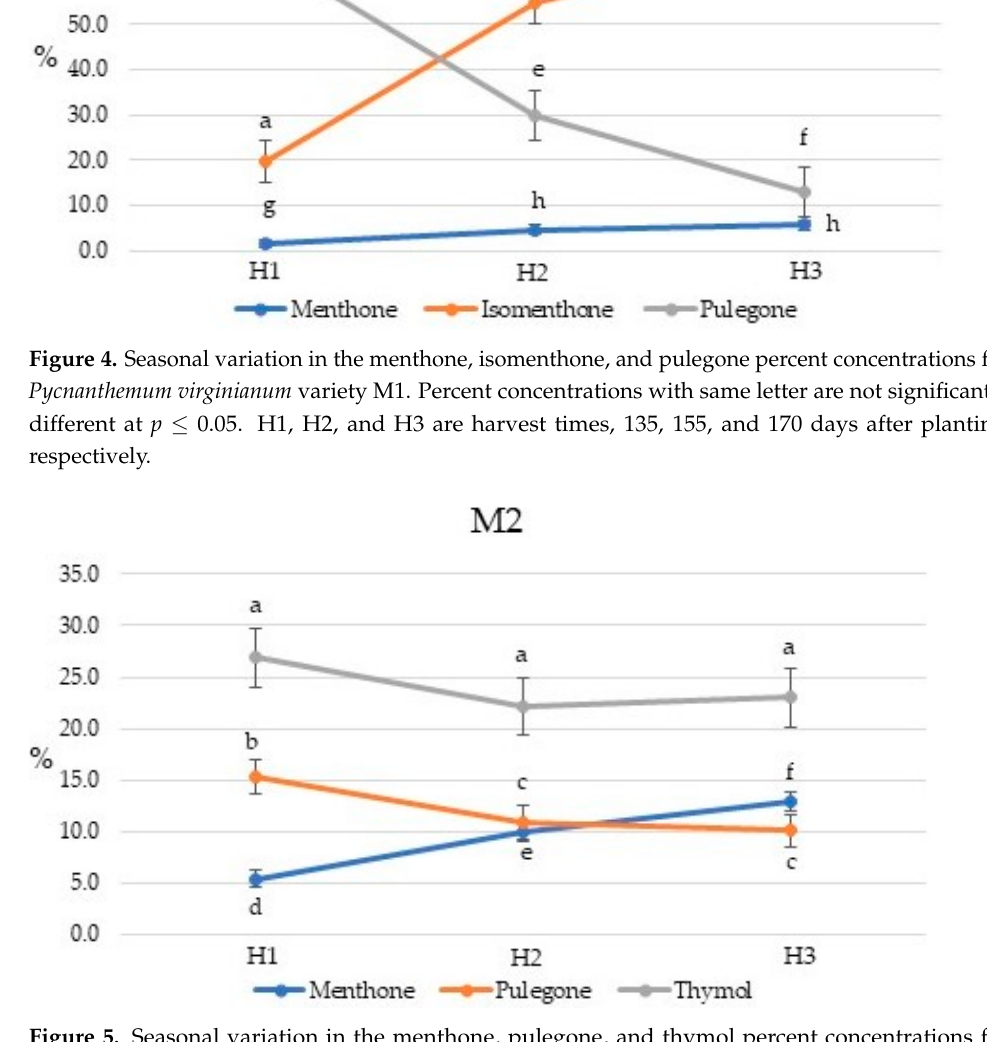
Figure 5. Seasonal variation in the menthone, pulegone, and thymol percent concentrations for Pycnanthemum virginianum variety M2. Percent concentrations with same letter are not significantly different at p ≤ 0.05. H1, H2, and H3 are harvest times, 135, 155, and 170 days after planting, respectively.